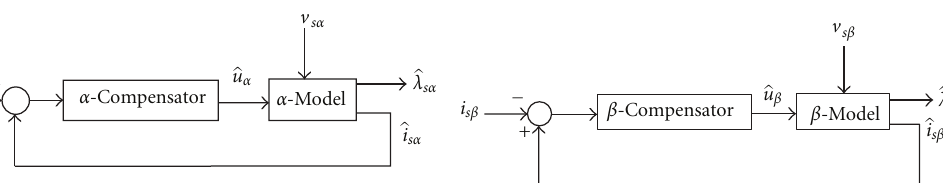
Figure 1: α - and β -Flux observer structures.